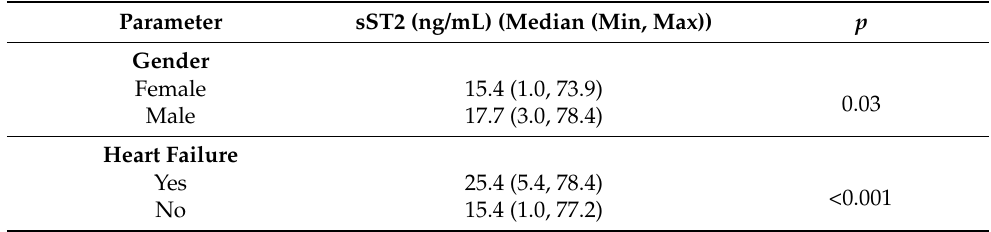
Table 2. Univariate correlates of categorical variables and sST2